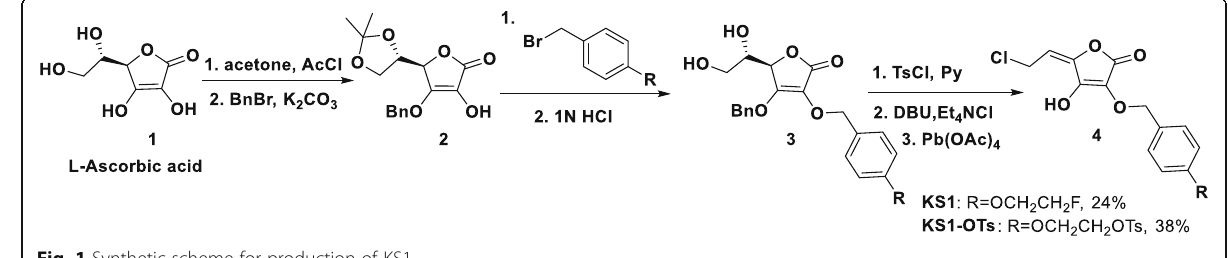
Fig. 1 Synthetic scheme for production of